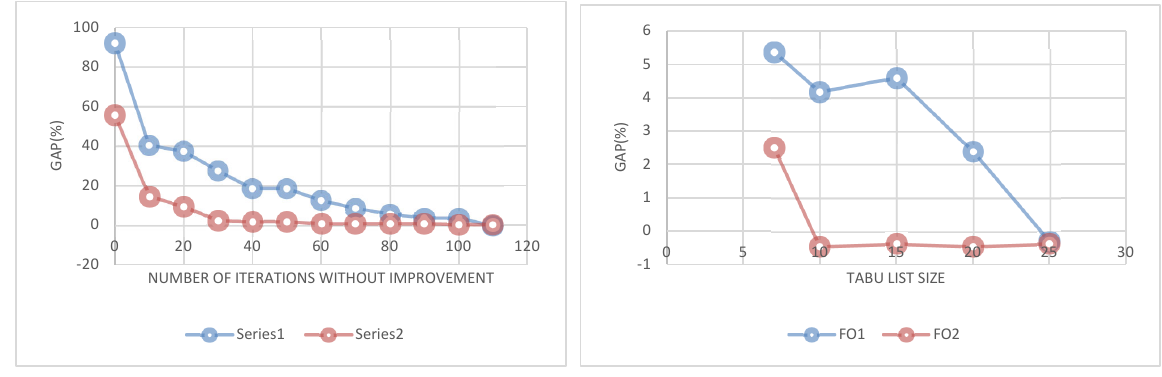
Fig. 5. Tabu List Parameter Graph. Own